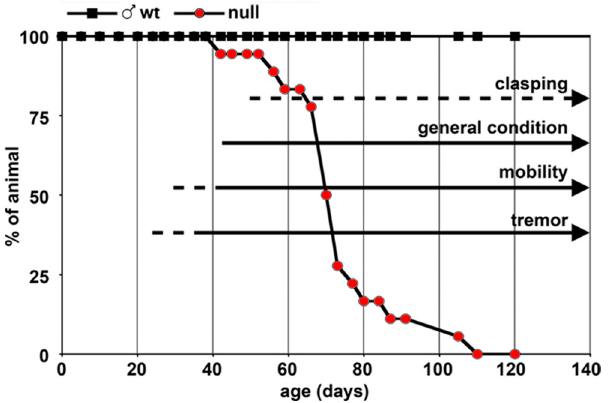
Fig 3. CD1 Mecp2 -null animals have a life span comparable to that of B6 null animals. CD1 null animals (red circles) are compared to wt controls (black squares). Arrows represent the timing of appearance of the different symptoms described in Fig 2 (dotted lines = 50 – 99% of animals have the given symptom, continuous line = 100% of the animals have the symptom; n = 18 Mecp2 -null).